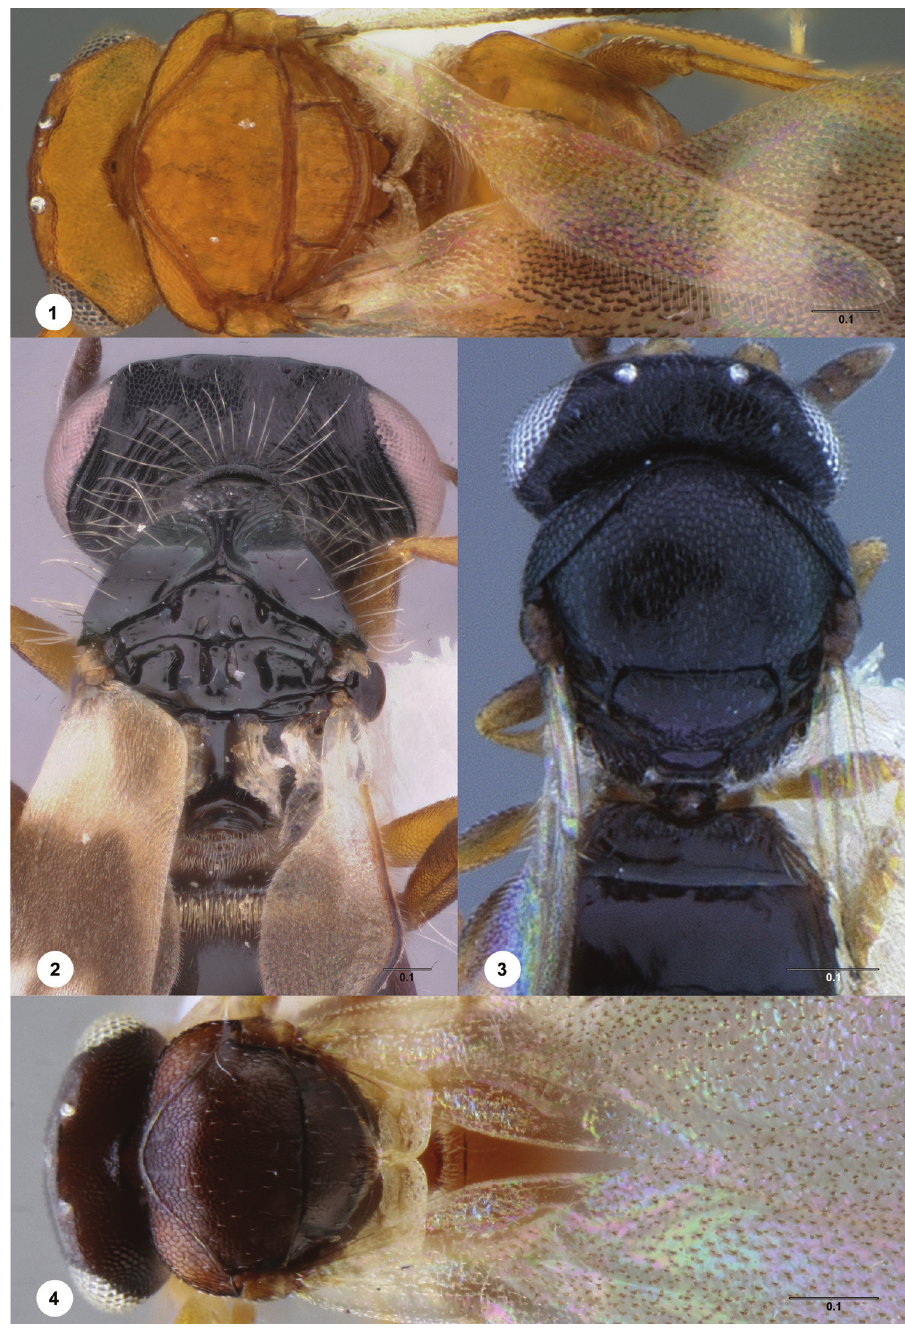
Figures 1–4. Genera of the Isolia -cluster. Pulchrisolia nephelae , male (USNMENT00916688) 1 head, meso- soma, metasoma, dorsal view. Sceliotrachelus braunsi Brues, female (OSUC 231999) 2 head, mesosoma, metas- oma, dorsal view. Afrisolia sp., female (USNMENT00916676) 3 head, mesosoma, metasoma, dorsal view. Iso- lia sp., female (USNMENT00197883) 4 head, mesosoma, metasoma, dorsal view. Scale bars in